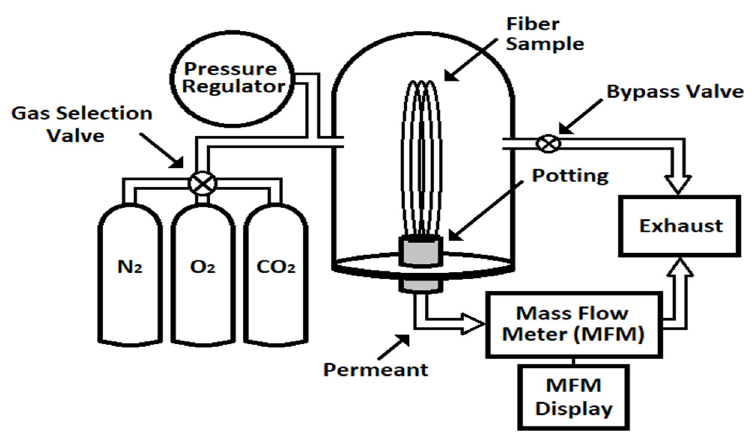
Figure 1. Schematic of the gas permeability apparatus.